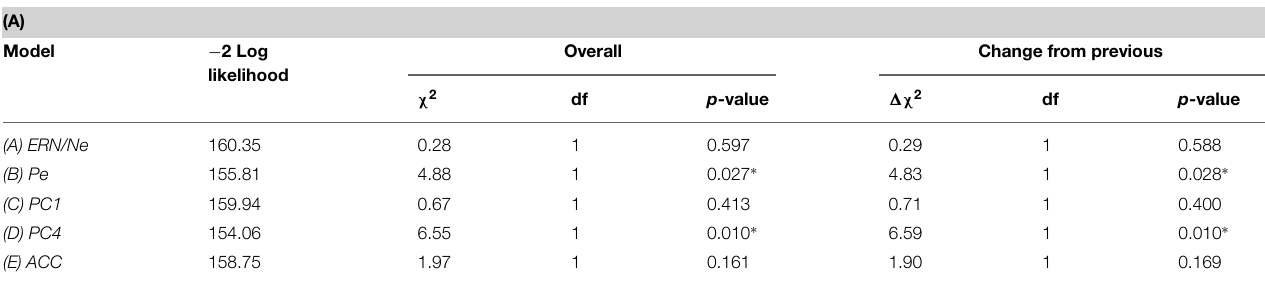
TABLE 3 | Zero-order Cox and logistic regressions with ERN/Ne, Pe, PC1, PC4, and ACC activation predicting rearrest ( N =